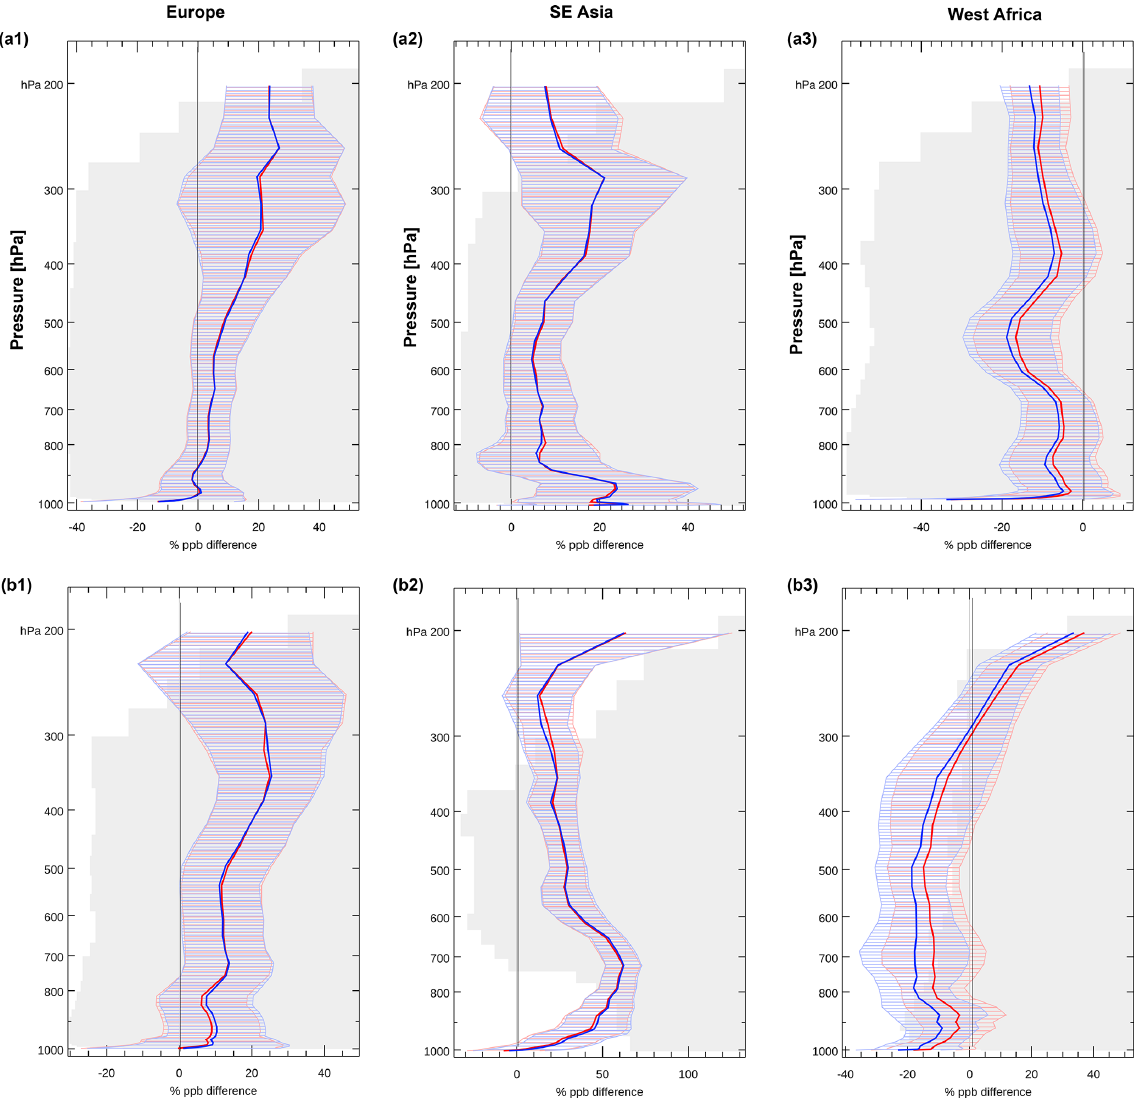
Figure 14. Mean relative O 3 difference in percent of ASSIM minus IAGOS aircraft data (red) and CTRL minus IAGOS (blue) for (a) FMA and (b) JAS 2018 averaged over (1) European airports, (2) SE Asian airports and (3) West African